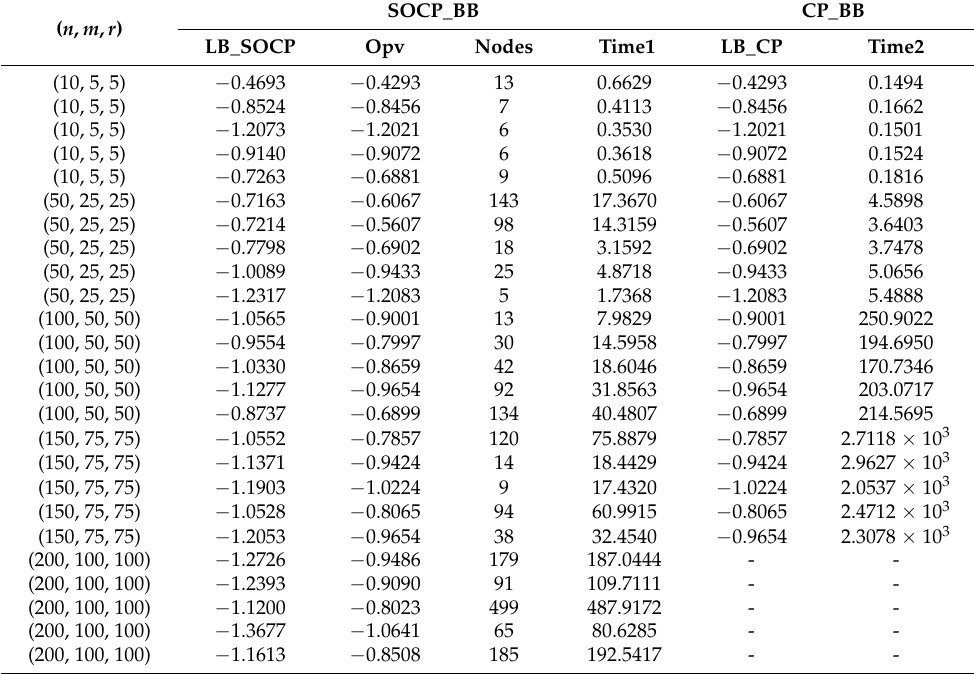
Table 1. Performance Comparisons of the enhanced SOCP relaxation and the CP relaxation